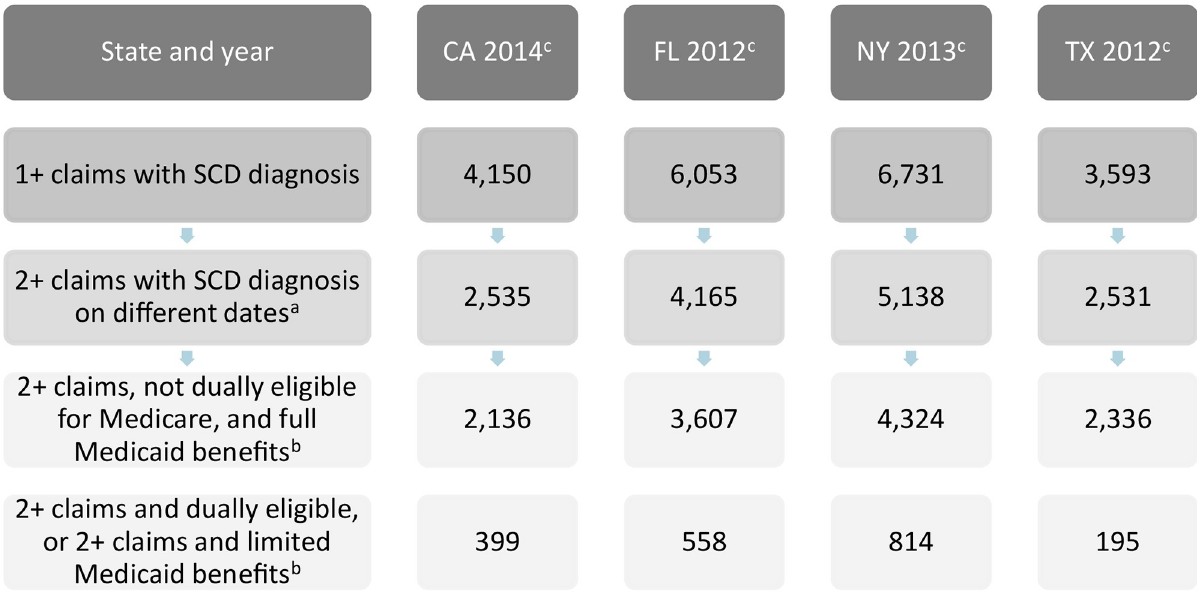
Fig 5. Medicaid SCD population size, by state and year. SCD is sickle cell disease.